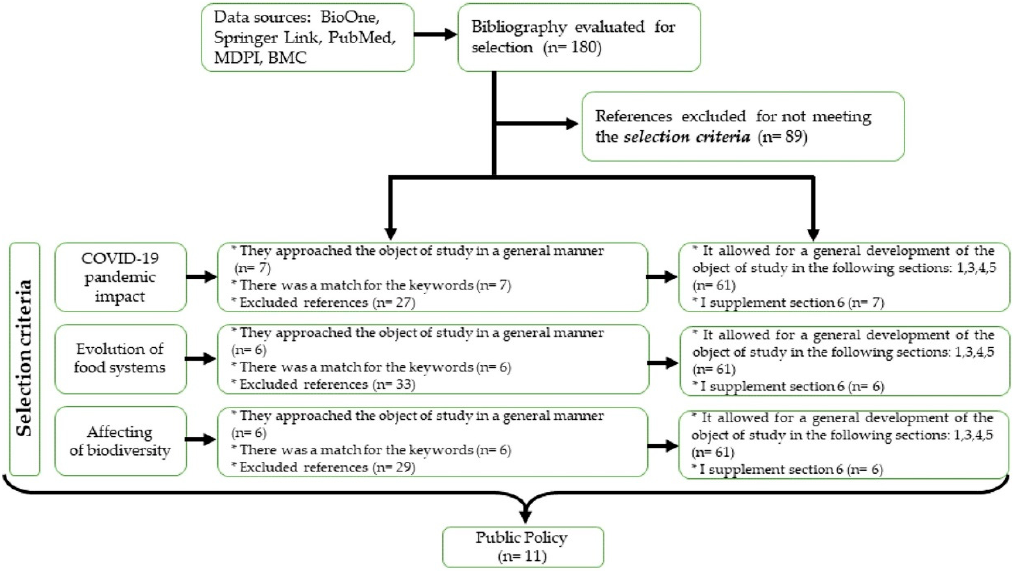
Figure 1 . Consort diagram of the bibliographic analysis of the study and selection criteria. Figure 1. Consort diagram of the bibliographic analysis of the study and selection